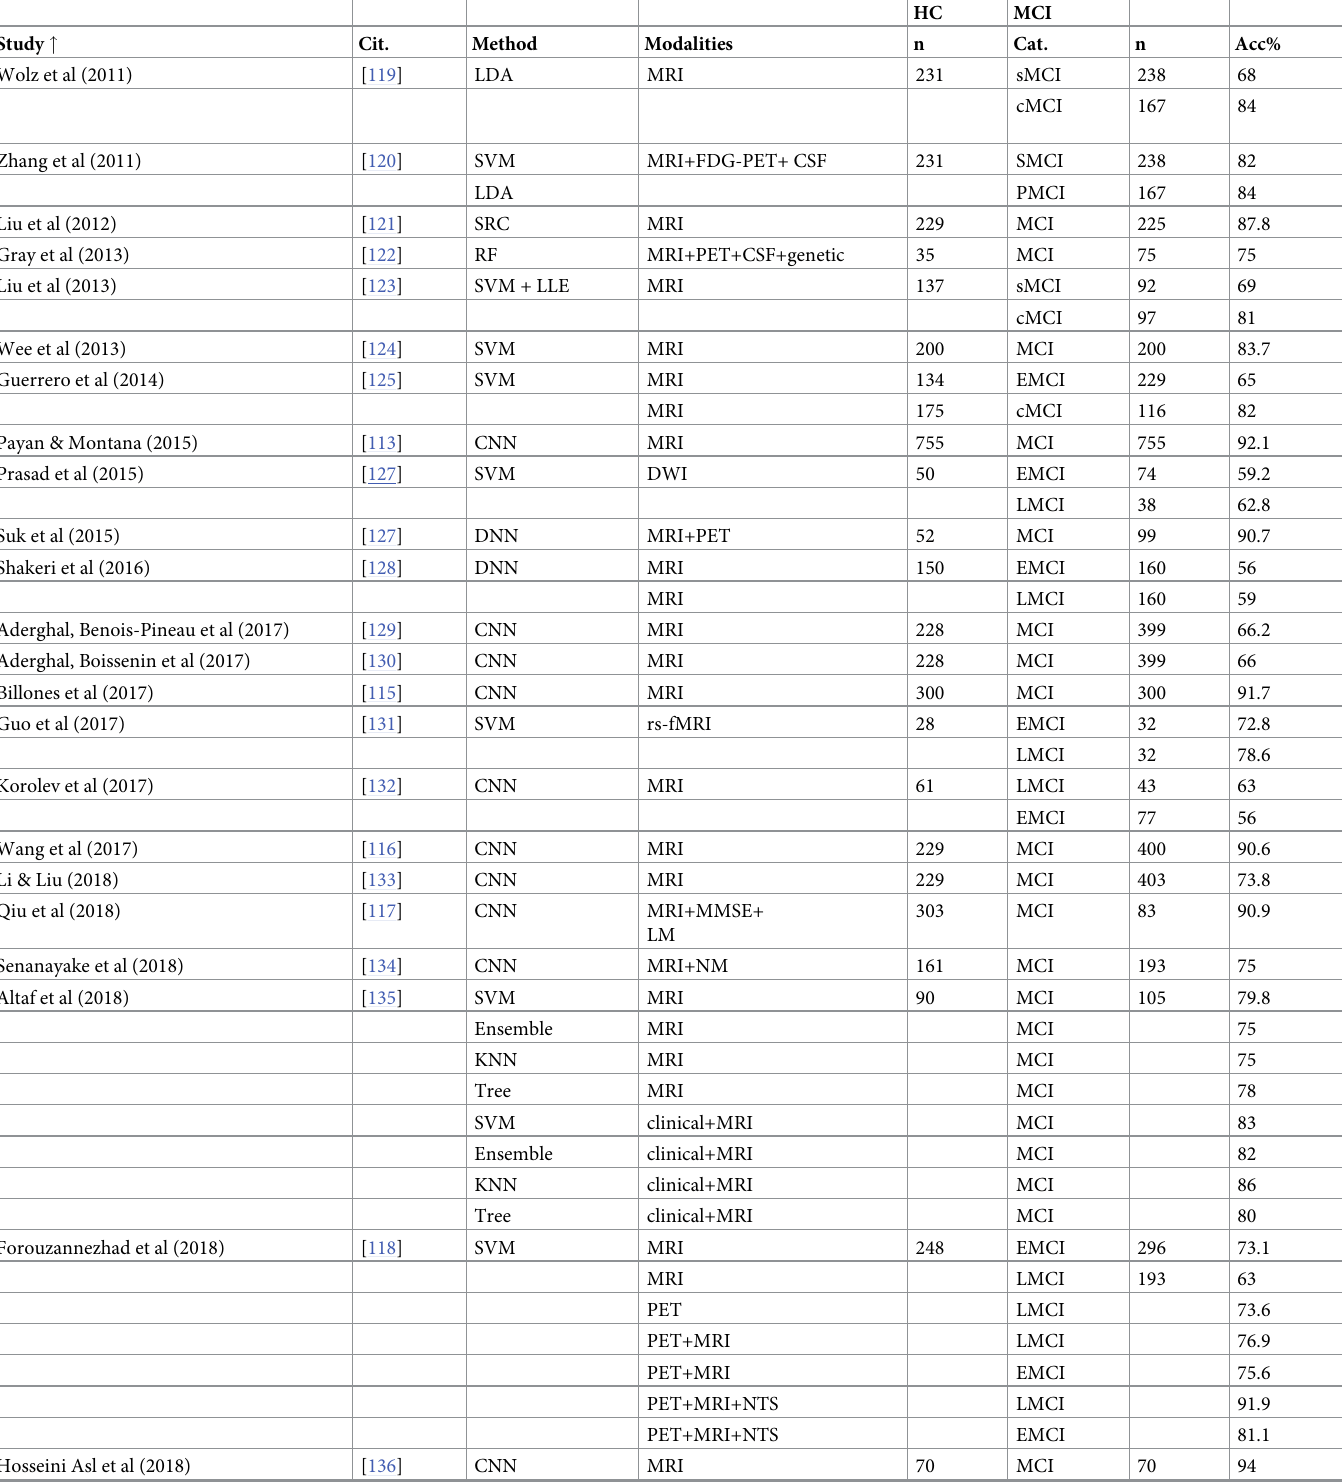
Table 3. Summary of the studies aiming at categorization of healthy (HC) and mild cognitive impairment (MCI) using different biomarkers and classification methods. Only best performance of each study is reported for each group of participants and classification method. Further details of the following studies are in S1